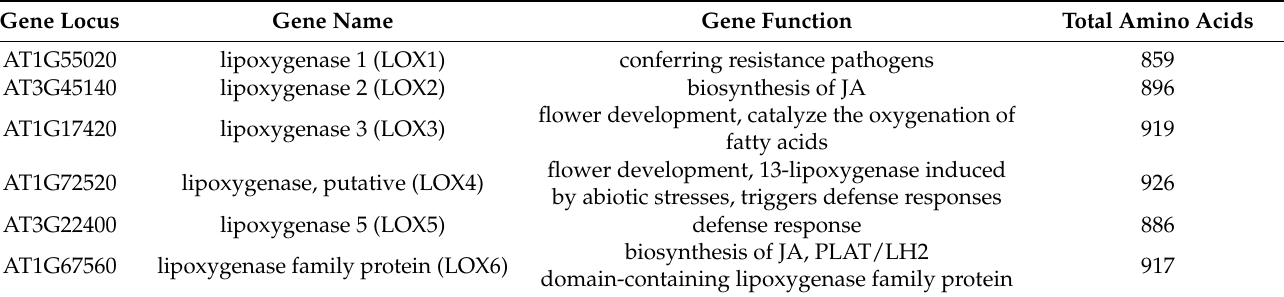
Table 1. Genes encoding LOX in Arabidopsis thaliana [38–42].